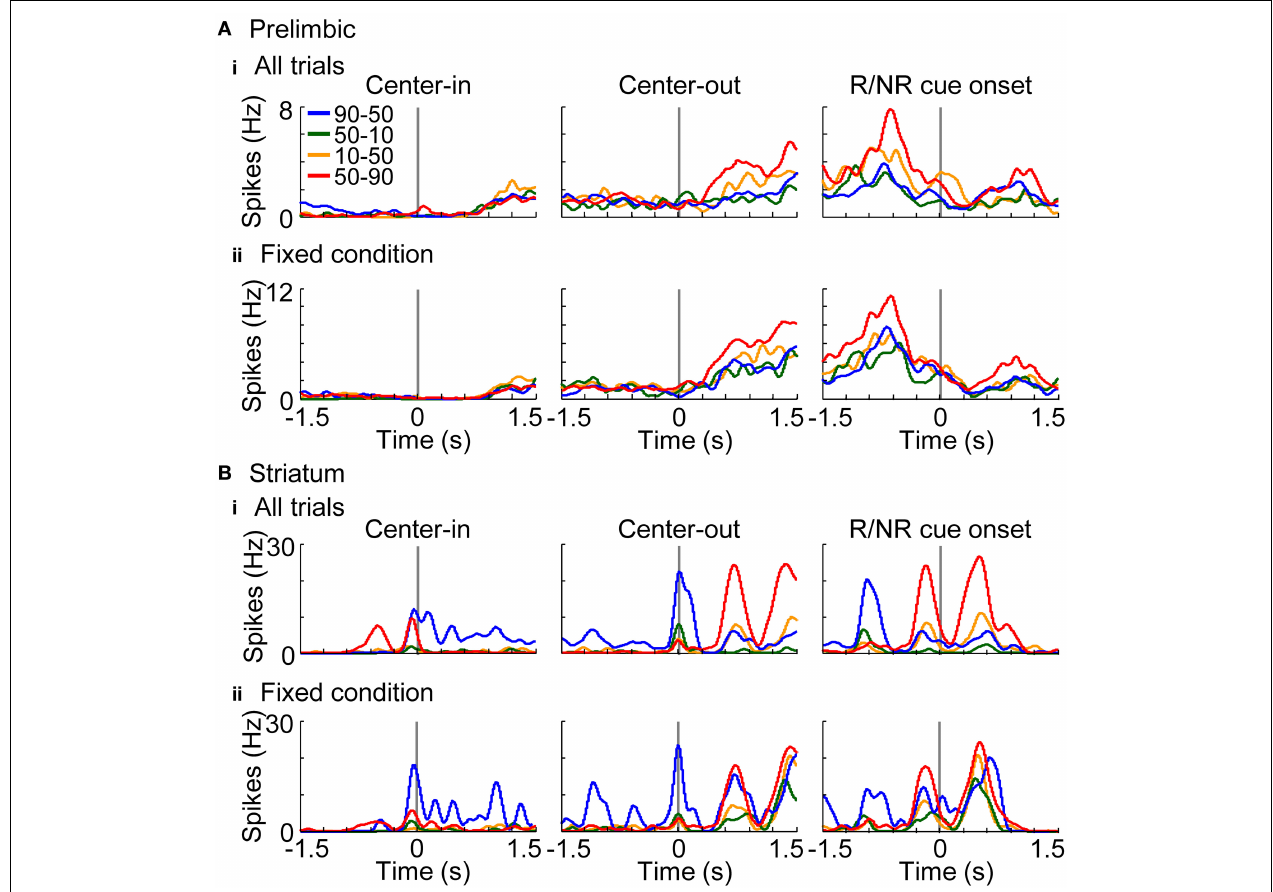
FIGURE 10 | Representative value-coding neuron. Representative neurons coding values of the variable-reward condition are shown from the prelimbic cortex (A) and dorsomedial striatum (B) . Average spike density functions during both the variable-reward-condition and fixed-reward-condition trials (i) and during the fixed-reward-condition trials (ii) are shown, smoothed with a Gaussian kernel with a standard deviation of 50ms. Each colored line shows the activity during a reward-probability